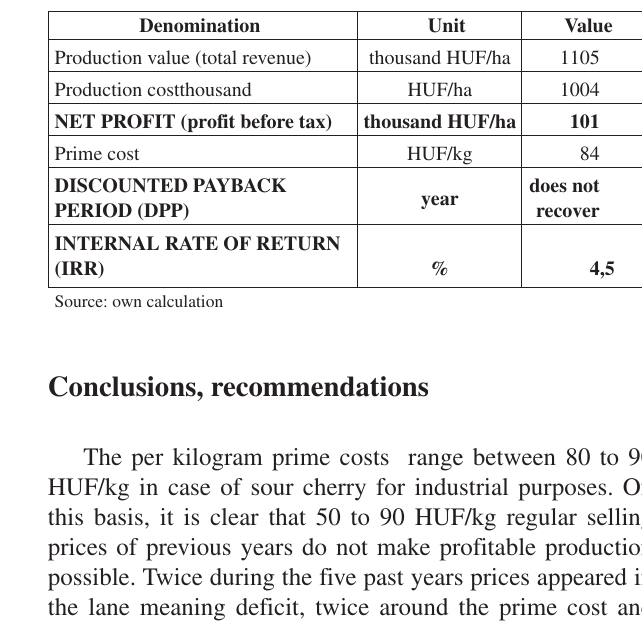
Table 5. Indicators of economic efficiency of orchard investment